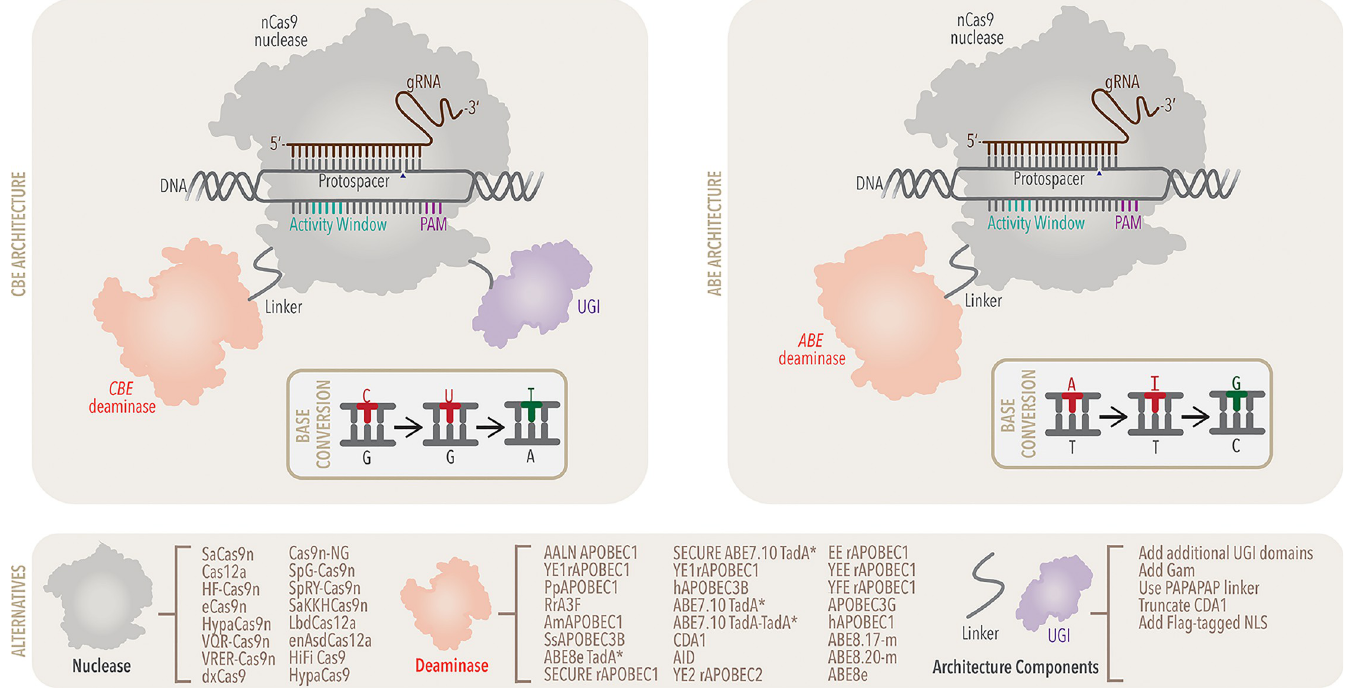
Fig 1. Overview of CBE and ABE principal components. Top left : CBE architecture shown with principal components: Cas9n in grey (outline of crystal structure obtained from PDB: 6VPC), CBE deaminase APOBEC3A in red (outline of crystal structure obtained from PDB: 5SWW), and UGI in purple (outline of crystal structure obtained from PDB: 1UGI). The deaminase and UGI components are tethered to nCas9 via short amino acid linkers (grey). Overlayed on top of the principal components is a general schematic of the mechanism of action; the gRNA (brown) will bind to the DNA protospacer (sequence of 20 nucleotides proximally located to the 3-nucleotide PAM (violet) sequence), in the process exposing a single-stranded DNA “bubble” open for cytosine deamination. Deamination produces a U•G intermediate, which is processed by the cell to produce an overall C•G to T•A conversion (shown in base conversion inset). Concurrently, nCas9 will nick the unedited DNA strand (blue triangle) to increase editing efficiency. Similarly, the addition of the UGI component increases editing efficiency. Top right : ABE architecture, simplified mechanism schematic, and overall base conversion are shown. Key differences of the ABE architecture are as follows: ABE deaminase TadA-8e, similarly in red, (outline of crystal structure obtained from PDB: 6VPC) replaces CBE deaminase and the lack of a UGI component, as ABE utilizes an inosine intermediate, compared to the CBE architecture. Bottom : A noncomprehensive sampling of notable variations on key CBE and ABE principal components are shown. Collectively, these substitute components serve an array of purposes including increased on-target editing, decreased off-target editing, and relaxed PAM requirements for broadened utility. Development of new and enhanced base editor principal components is a populated field of study with new results being published rapidly. ABE AU : AbbreviationlistshavebeencompiledforthoseusedinFig 1 : Pleaseverifythatallentriesarecorrect : , adenine base editor; AID, activation-induced cytidine deaminase; AmAPOBEC1, Alligator mississippiensis APOBEC1; APOBEC, Apolipoprotein B mRNA editing enzyme, catalytic polypeptide; CDA1, cytidine deaminase 1 sourced from sea lamprey; Cas9n, Cas9 nickase; CBE, cytosine base editor; dxCas9, catalytically dead expanded PAM Cas9; eCas9, enhanced specificity Cas9; enAsdCas12a, enhanced Acidaminococcus sp. BV3L6 catalytically dead Cas12a gRNA, guide RNA; hAPOBEC, human APOBEC; HiFi Cas9, high fidelity Cas9 variant; HF-Cas9, high fidelity Cas9 variant; HypaCas9, hyper accurate Cas9; LbdCas12a, catalytically